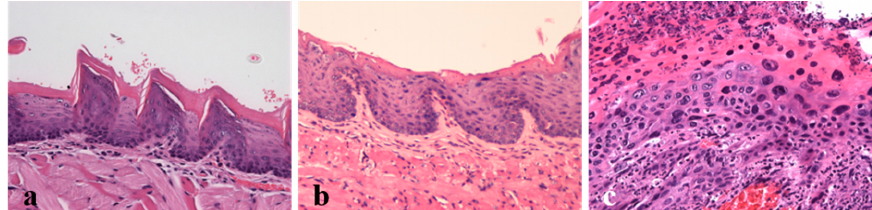
Figure 2. Lesions induced by the HPV16 early genes were analyzed histologically (H&E, 200×). ( a ) Dorsal tongue. Normal oral mucosa (HPV − mouse, Group 1); ( b ) Dorsal tongue. Hyperplastic changes in the oral mucosa (HPV + mouse, Group 3). Note the increased cellularity of the basal layers and normal epithelial differentiation. ( c ) Dorsal tongue. Squamous cell carcinoma (HPV + mouse, Group 3). Note the intense cell pleomorphism and disrupted epithelial architecture.